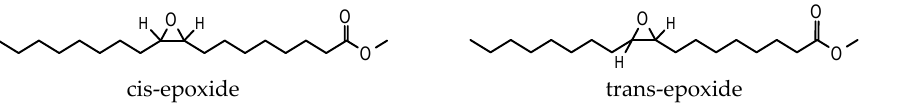
Figure 9. Energy dependent cis-trans isomerization of methyl oleate and methyl elaidate. This mechanism is declared as a possibility as to how the trans-9,10-epoxide could be formed.